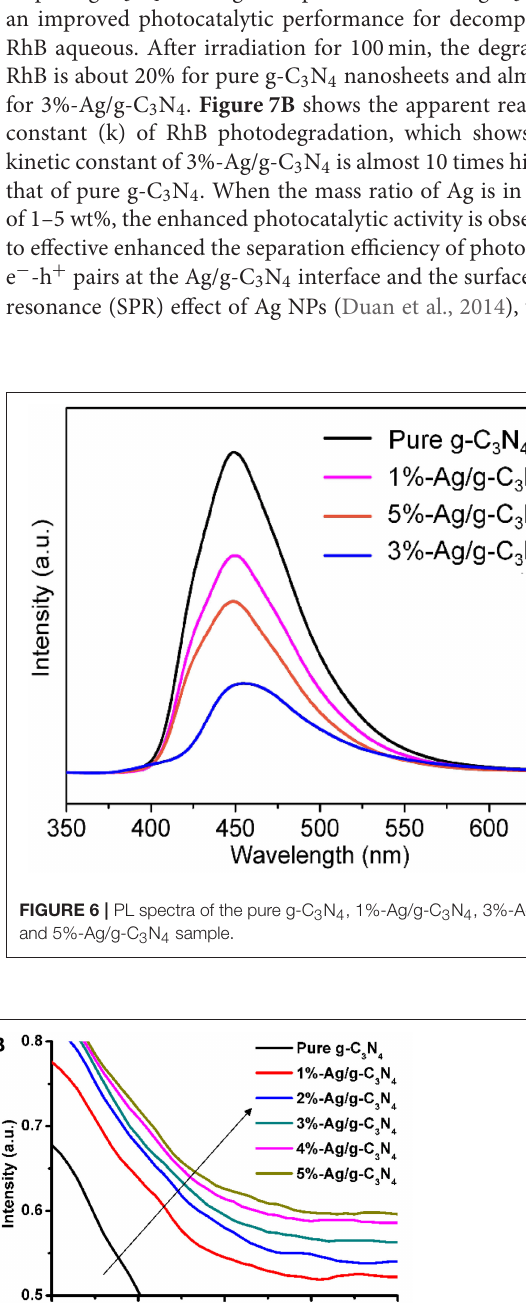
Frontiers in Chemistry |